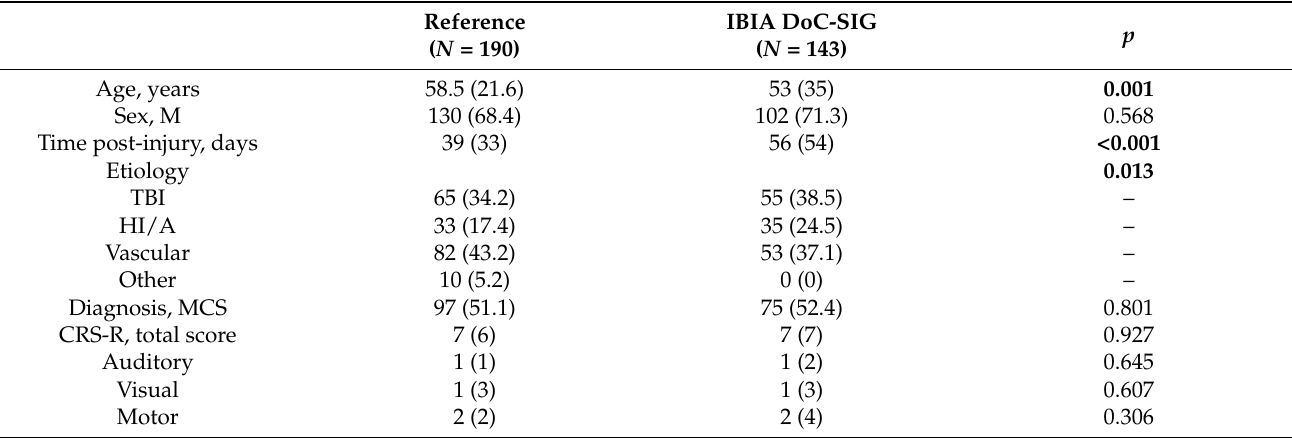
Table 1. Demographic, anamnestic, and clinical characteristics at baseline of included patients in the reference and validation